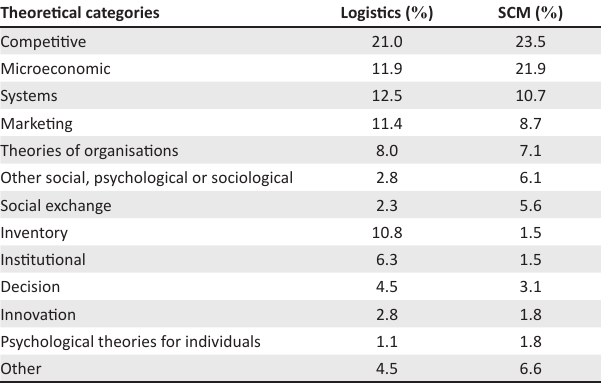
TABLE 7: Breakdown of theoretical categories by logistics and supply chain management